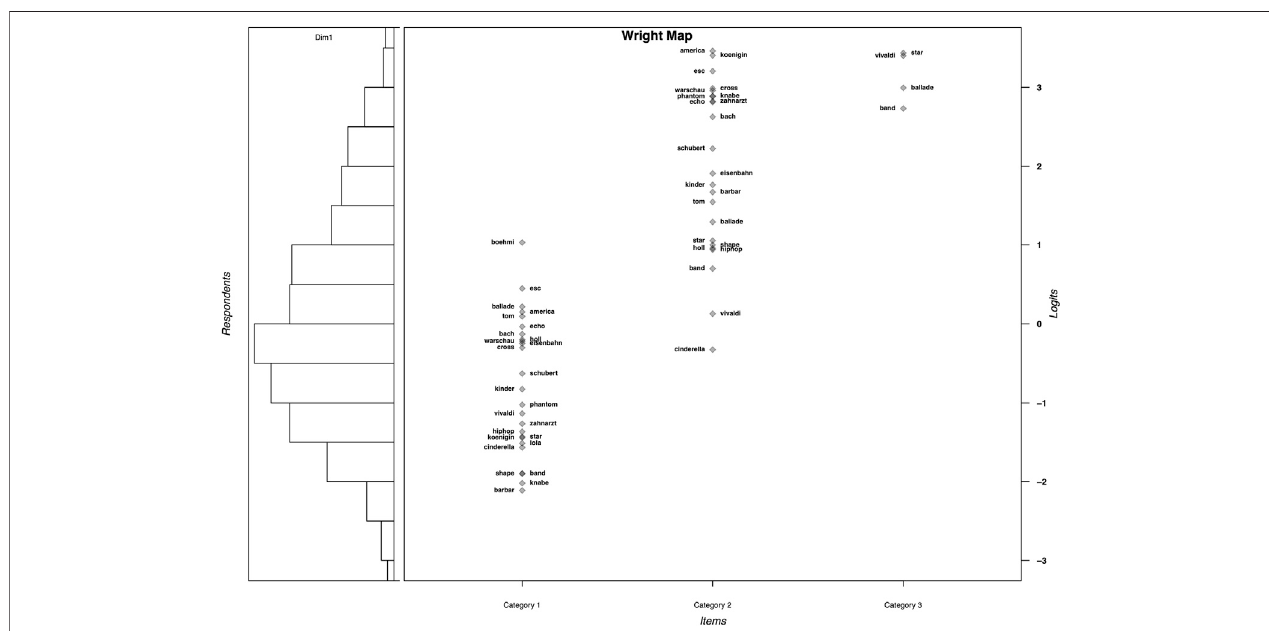
FIGURE 3 | Wright map (person-item map) with item categories ordered by 65% solution probability. On this map, the dif fi culty of the item response categories (Thurstonian thresholds) are placed on the same metric scale as the pro fi ciency scores (person ability measures). The left side of the fi gure shows a histogram of the pro fi ciency scores and the right side shows the dif fi culty of the item categories.